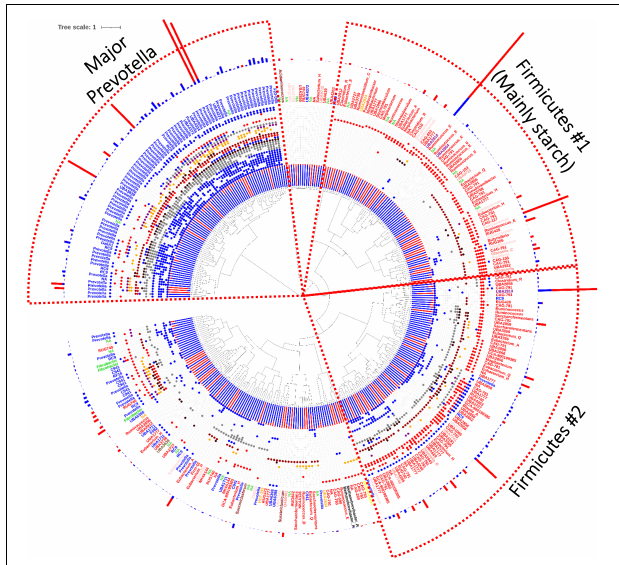
FIGURE 4 | A dendrogram of the 348 bins found in the microbiome, which had a significant change in abundance between the Standard and the Extreme feeding groups ( t -test, p -value < 0.05). In the dendrogram (in the center of the Figure), the bins are clustered based on the presence or absence of enzymes targeting different polysaccharide linkages, a novel approach to analyzing enzyme profile relatedness. The inner red and black-stacked bar plot indicates the relative abundance of the individual bin in the Standard (red) and the Extreme (black) groups. The 26 dots in different colors are indicating if a specific linkage target is present (colored) or absent (white). Pectin (blue), xylan (gray), starch (red), inulin (purple), other glucans (orange), cellulose (dark red), xyloglucan (brown). Only those 26 linkages found to be significantly changed between the Standard and the Extreme groups are included (the linkage targets included in Table 5 and continued in Table 6 ). The linkage targets are in the same order as those in Tables 5 , 6 , starting with “Pectin::Arabinogalactan:: α -1,3/ α -1,5::Ara” closest to the center. The small font text label states the assigned genus of the bin, whereas the color